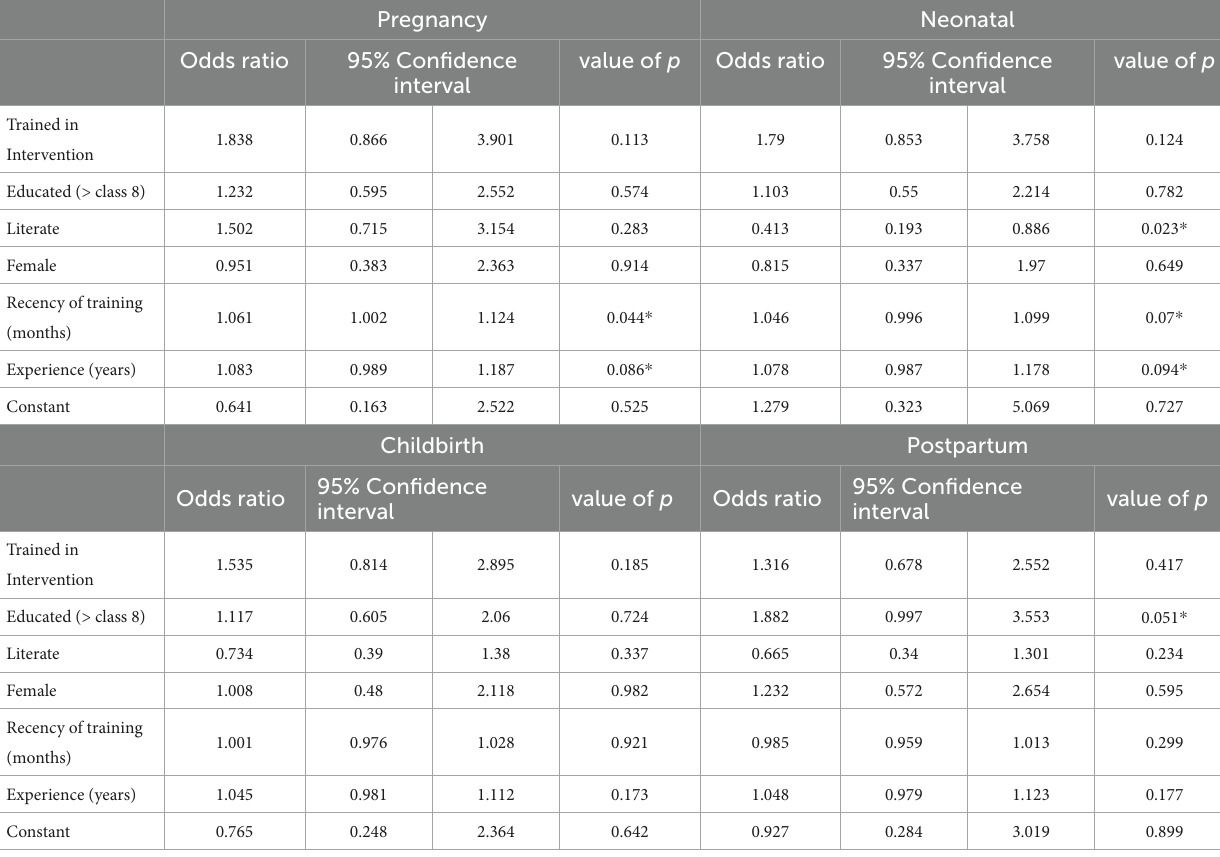
TABLE 4 Logistic regressions, knowledge.